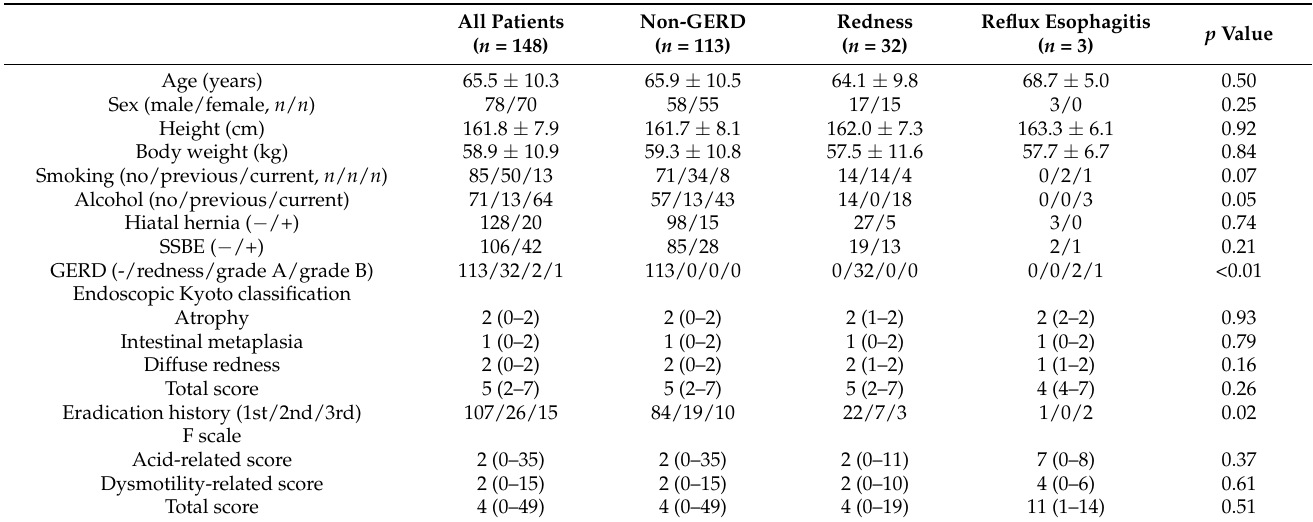
Table 1. Characteristics of patients positive for Helicobacter pylori at baseline. All Patients ( n =